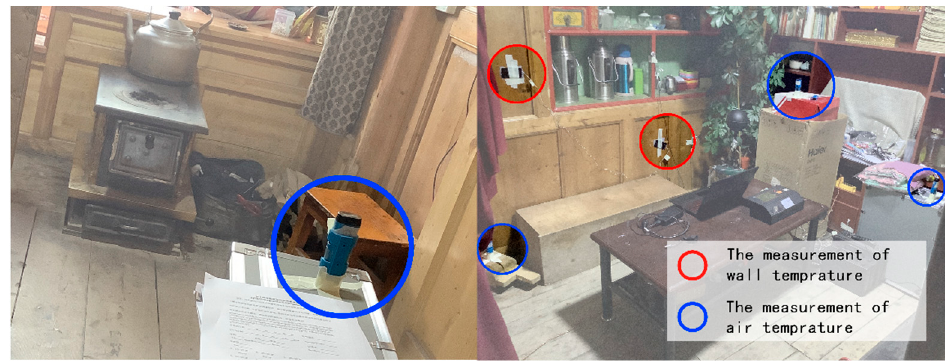
Figure 9. Picture of layout (source: self-drawn).